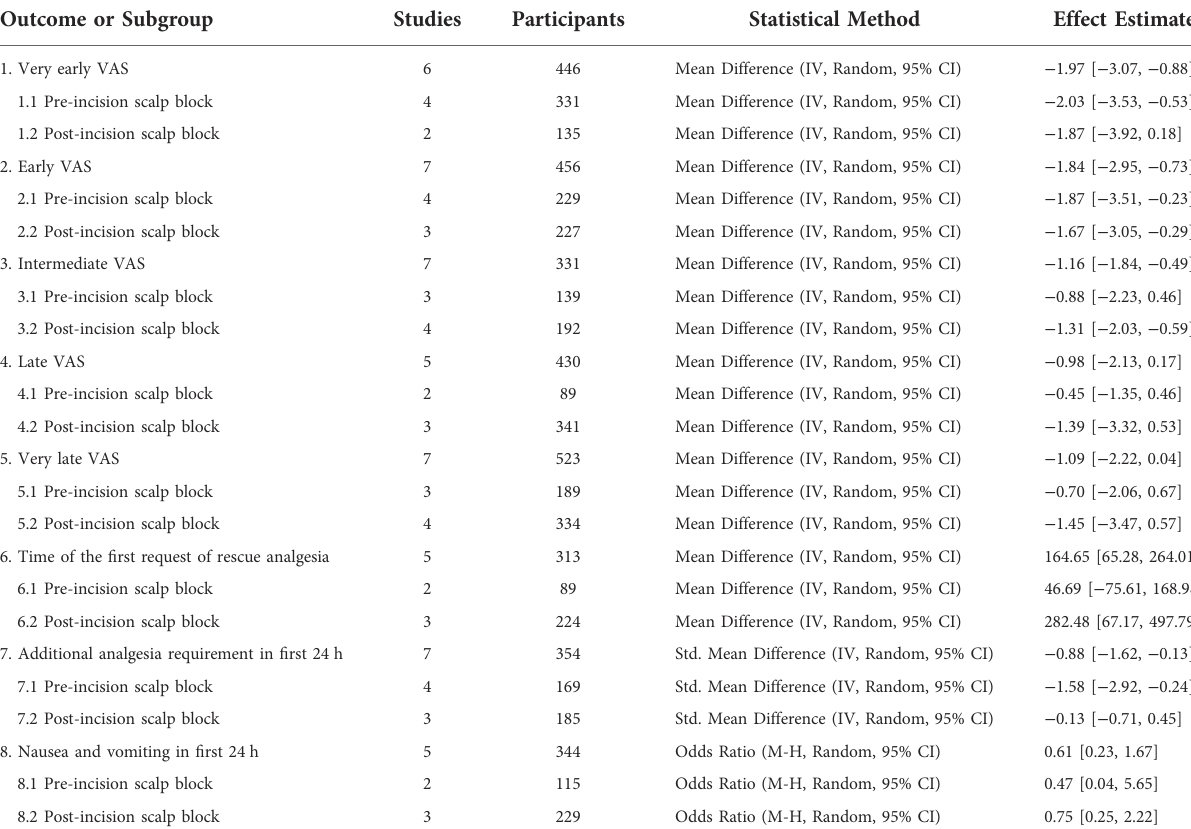
TABLE 2 Summary of meta-analysis results. Outcome or